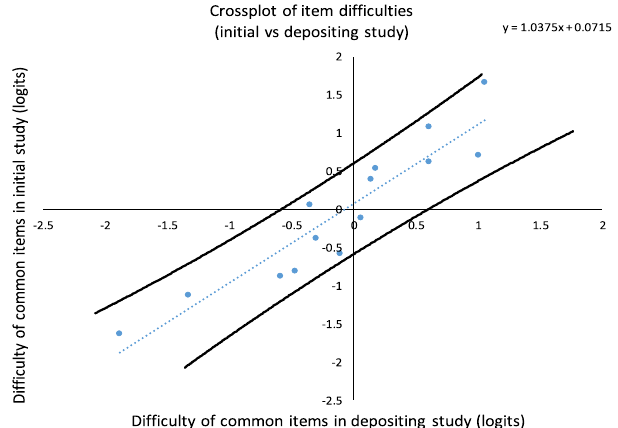
FIG. 1. Line of best fit for cross plot of difficulties of common items from the initial and depositing study, as well as a 95% confidence band are shown as evidence that difficulties of common items are invariant within the limits of measurement